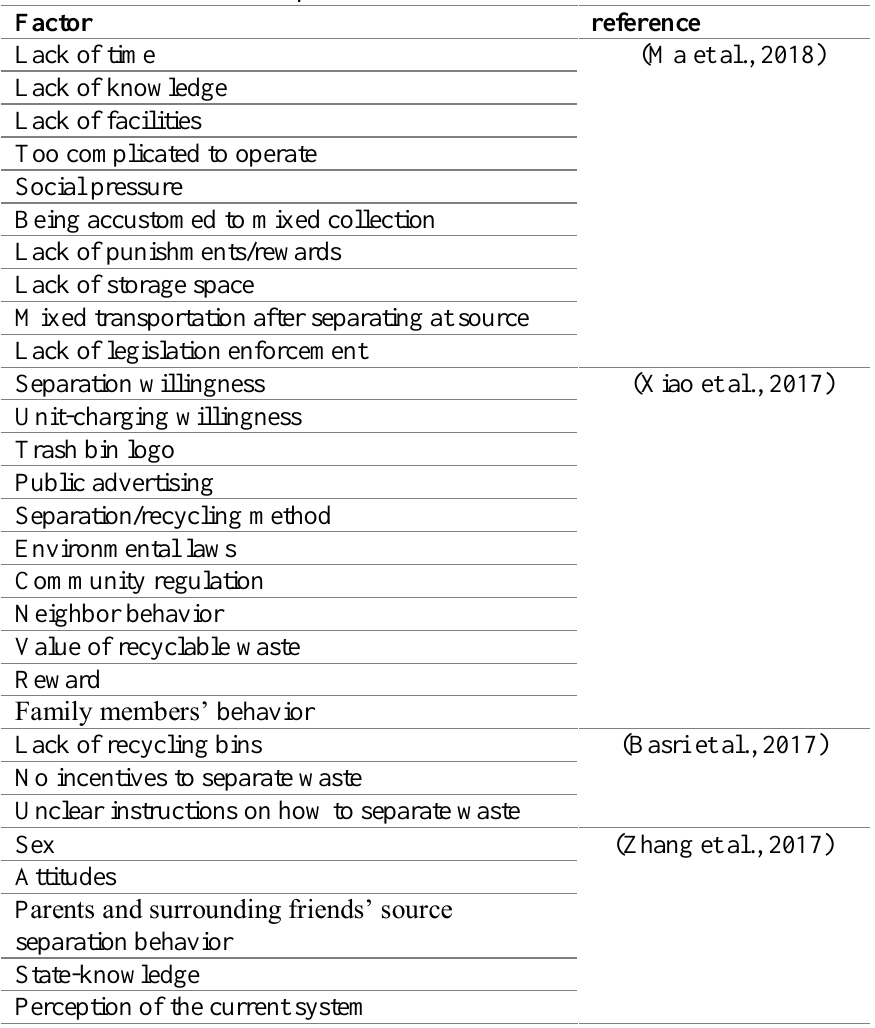
Table 1. Waste source separation